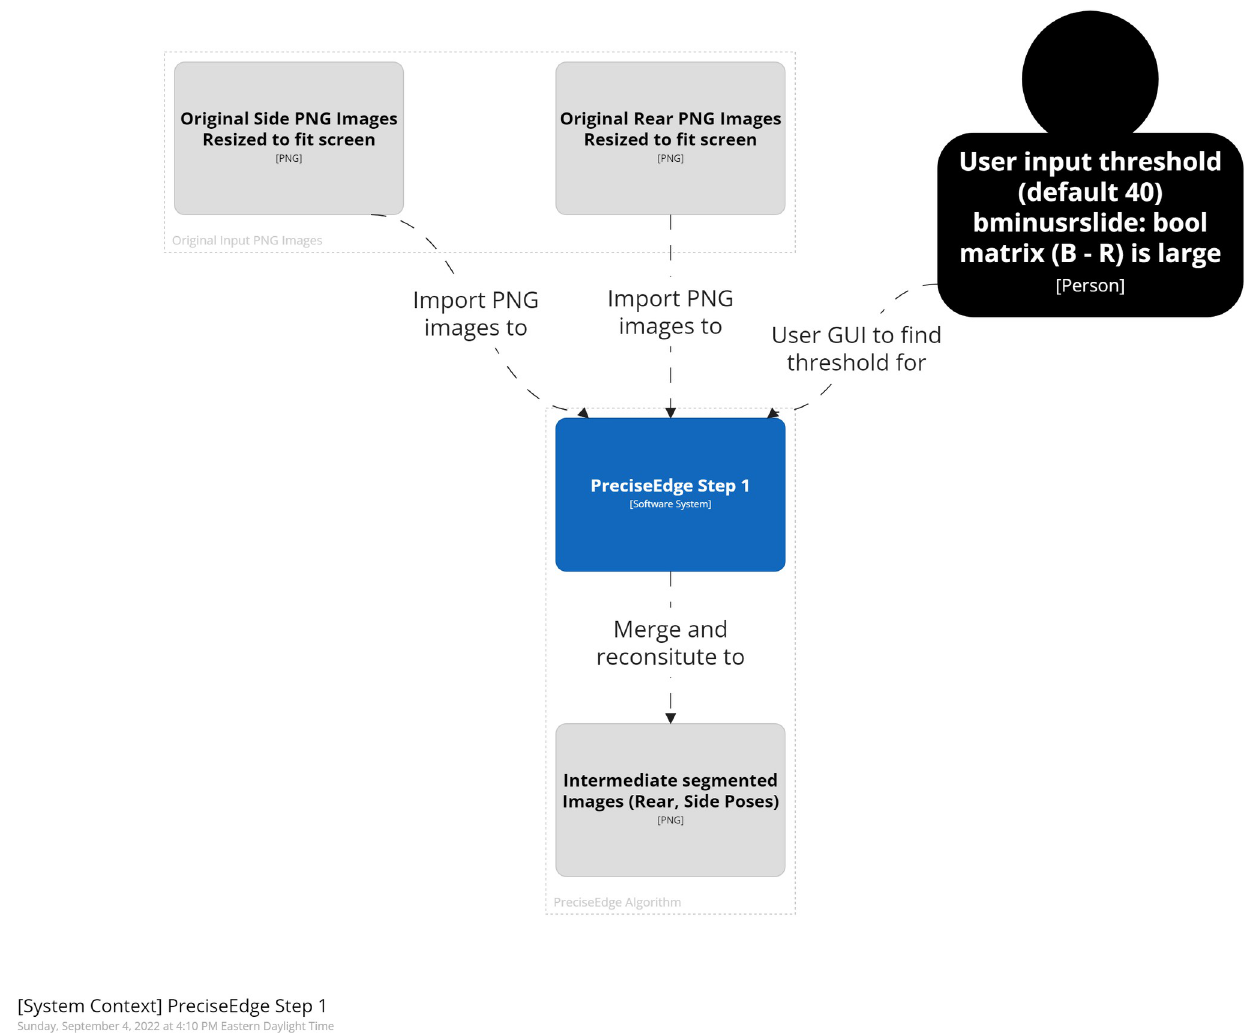
Fig 3. PreciseEdge algorithm step 1